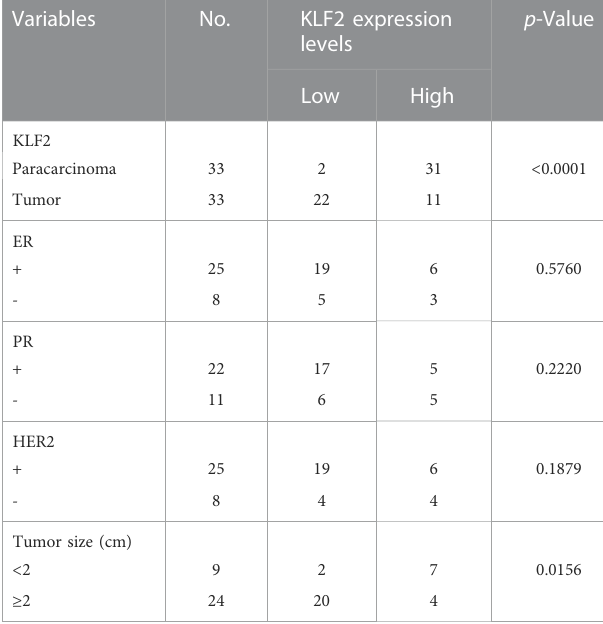
TABLE 1 Associations between KLF2 expression levels and clinic-pathologic parameters in breast cancer patients.